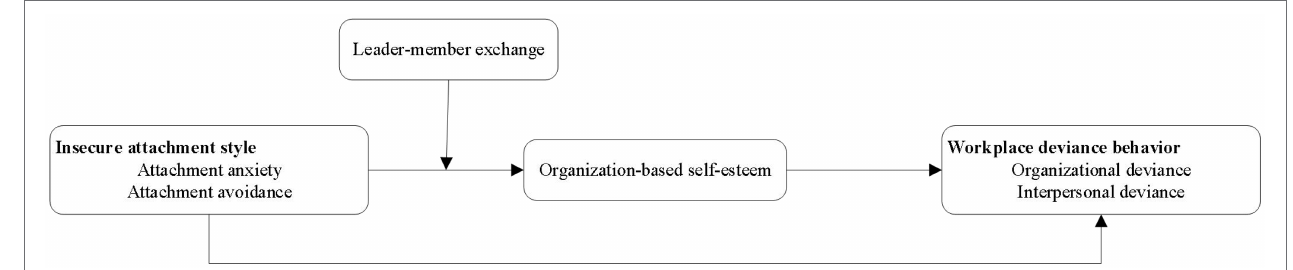
FIGURE 1 | The conceptual model of this